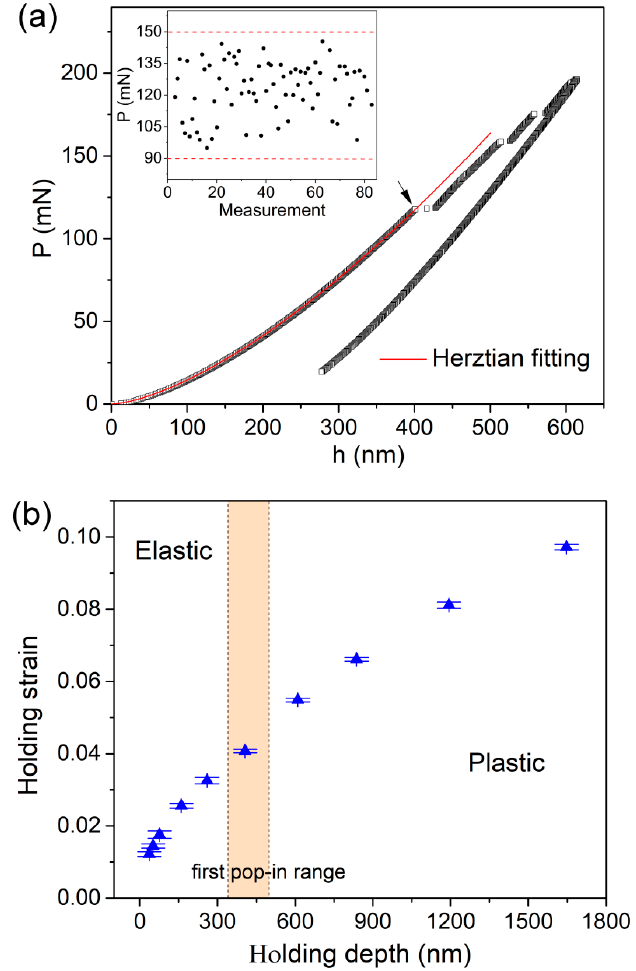
Figure 3. ( a ) The typical P-h curve under 200 mN spherical indenter with 5 s holding. The distribution range of the critical load at the first pop-in event is shown in the inset, which was plotted with measurement. ( b ) The corresponding holding strain for each holding load was calculated for spherical nanoindentation and was plotted with holding depth. The creep tests could be divided as elastic holding and plastic holding.